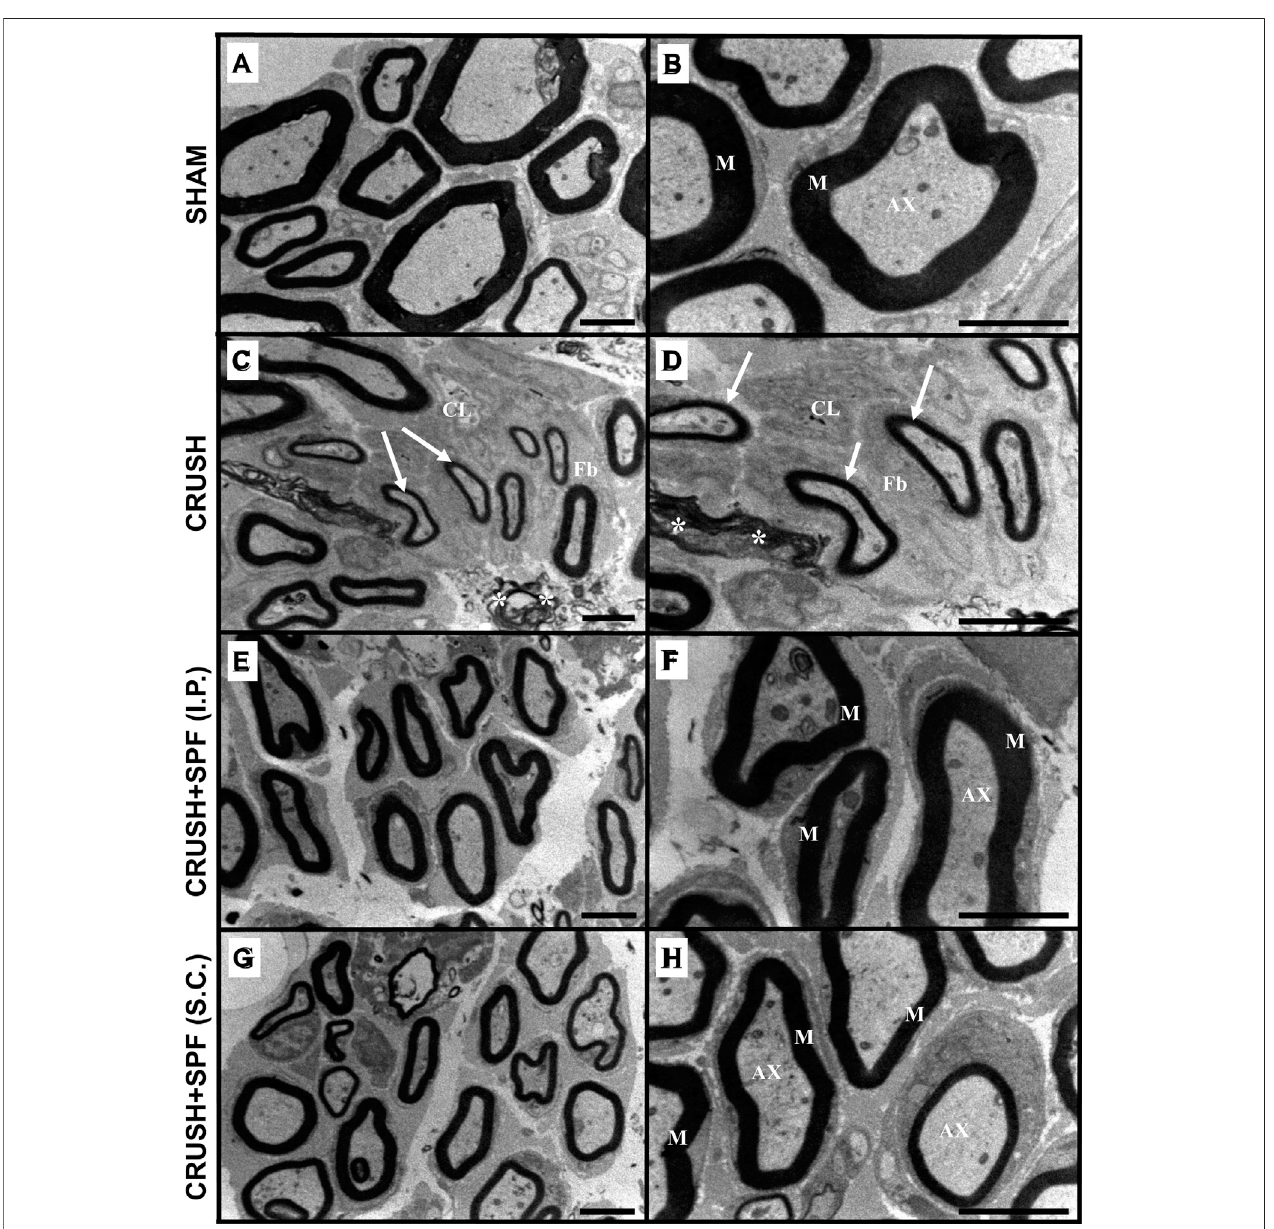
FIGURE 4 | Electron micrographs of the sciatic nerve from the SHAM (A,B) , CRUSH (C,D) , and CRUSH + SPF-FB(IP) (E,F) and CRUSH + SPF-FB(S.C.) (G,H) groups at week 6 post-injury. Note that the majority of the axons and nerve fi bers are still small in size and thinly myelinated (arrows) with a noticeable amount of extracellular cells (CL) and collagen fi bers (Fb) fi bers along with disintegrated and remnants of myelin scattered in between the axons (asterisk) in CRUSH nerves. SPF- FB-treatedcrushedsciatic (E,G,H) nervesshowednormal,healthyappearingmyelinsheaths,withnormalthicknessandnormalapparentaxons.M-myelinsheath; AX- axons. Scale bar (cid:2) 1